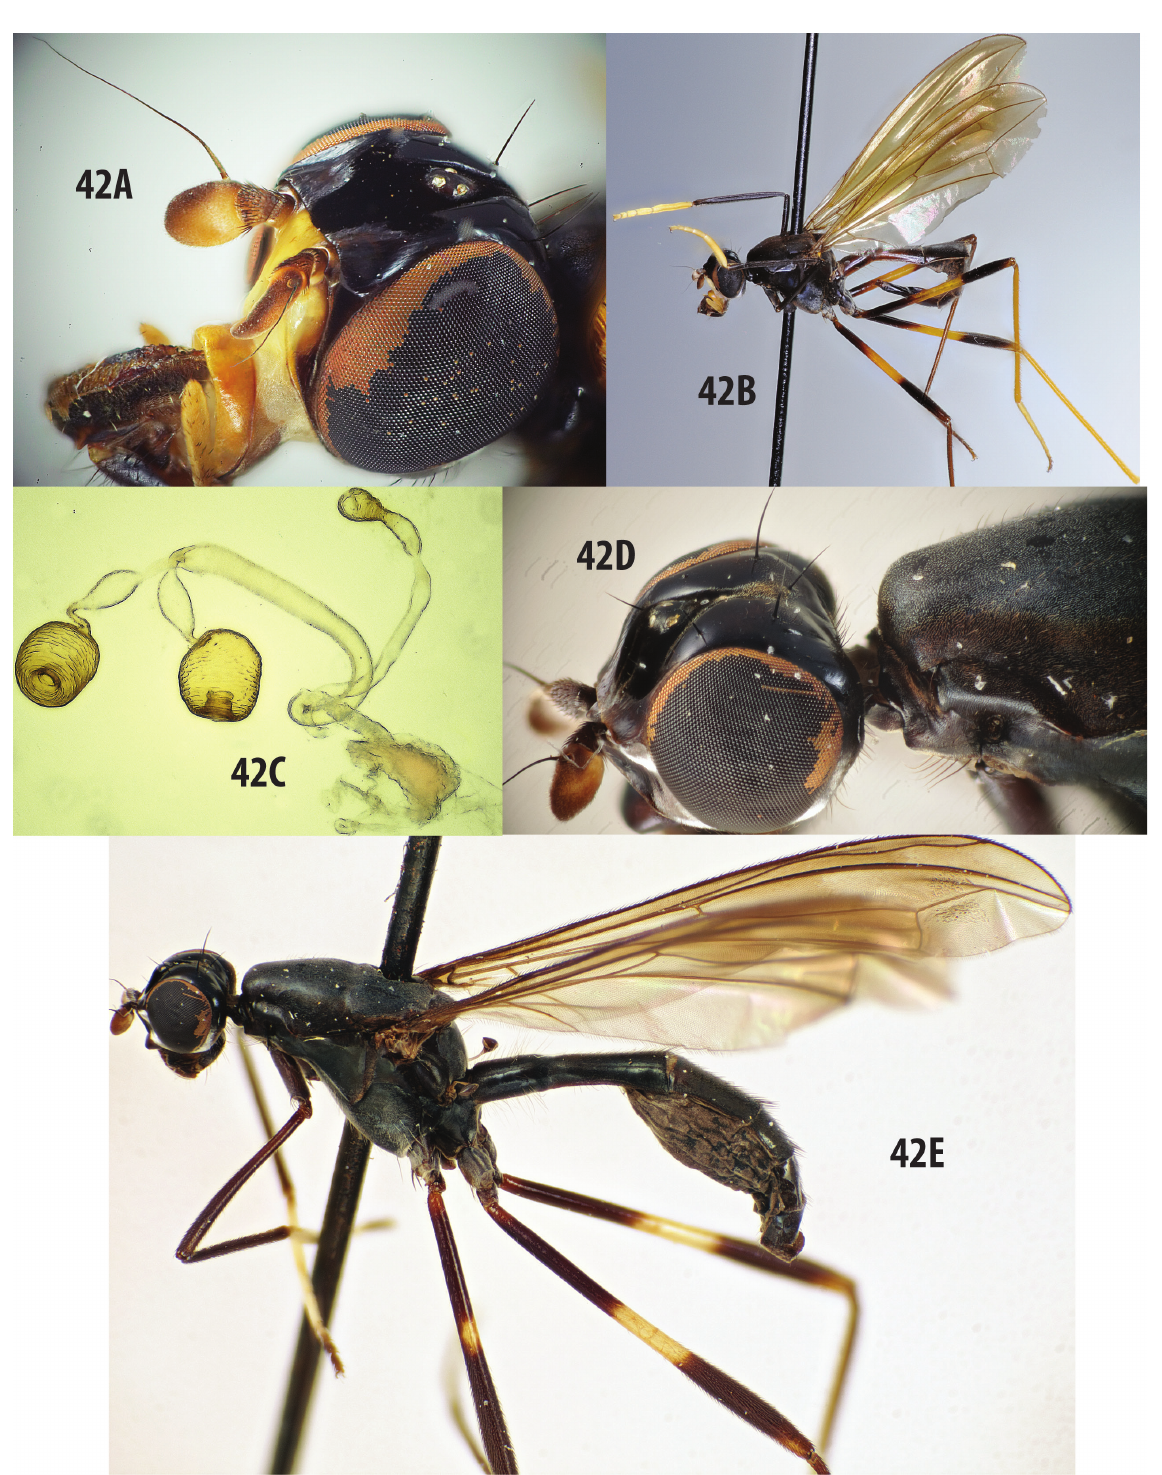
Fig. 42. A–C . Mesoconius gelbifacies sp. nov. A–B . Holotype, ♀, QCAZ. C . Spermathecae and associated structures. — D–E . M. keili sp. nov., holotype, ♀, QCAZ, oviscape